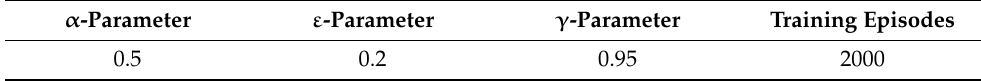
Table 1. RL Parameter Setting. α -Parameter ε -Parameter γ